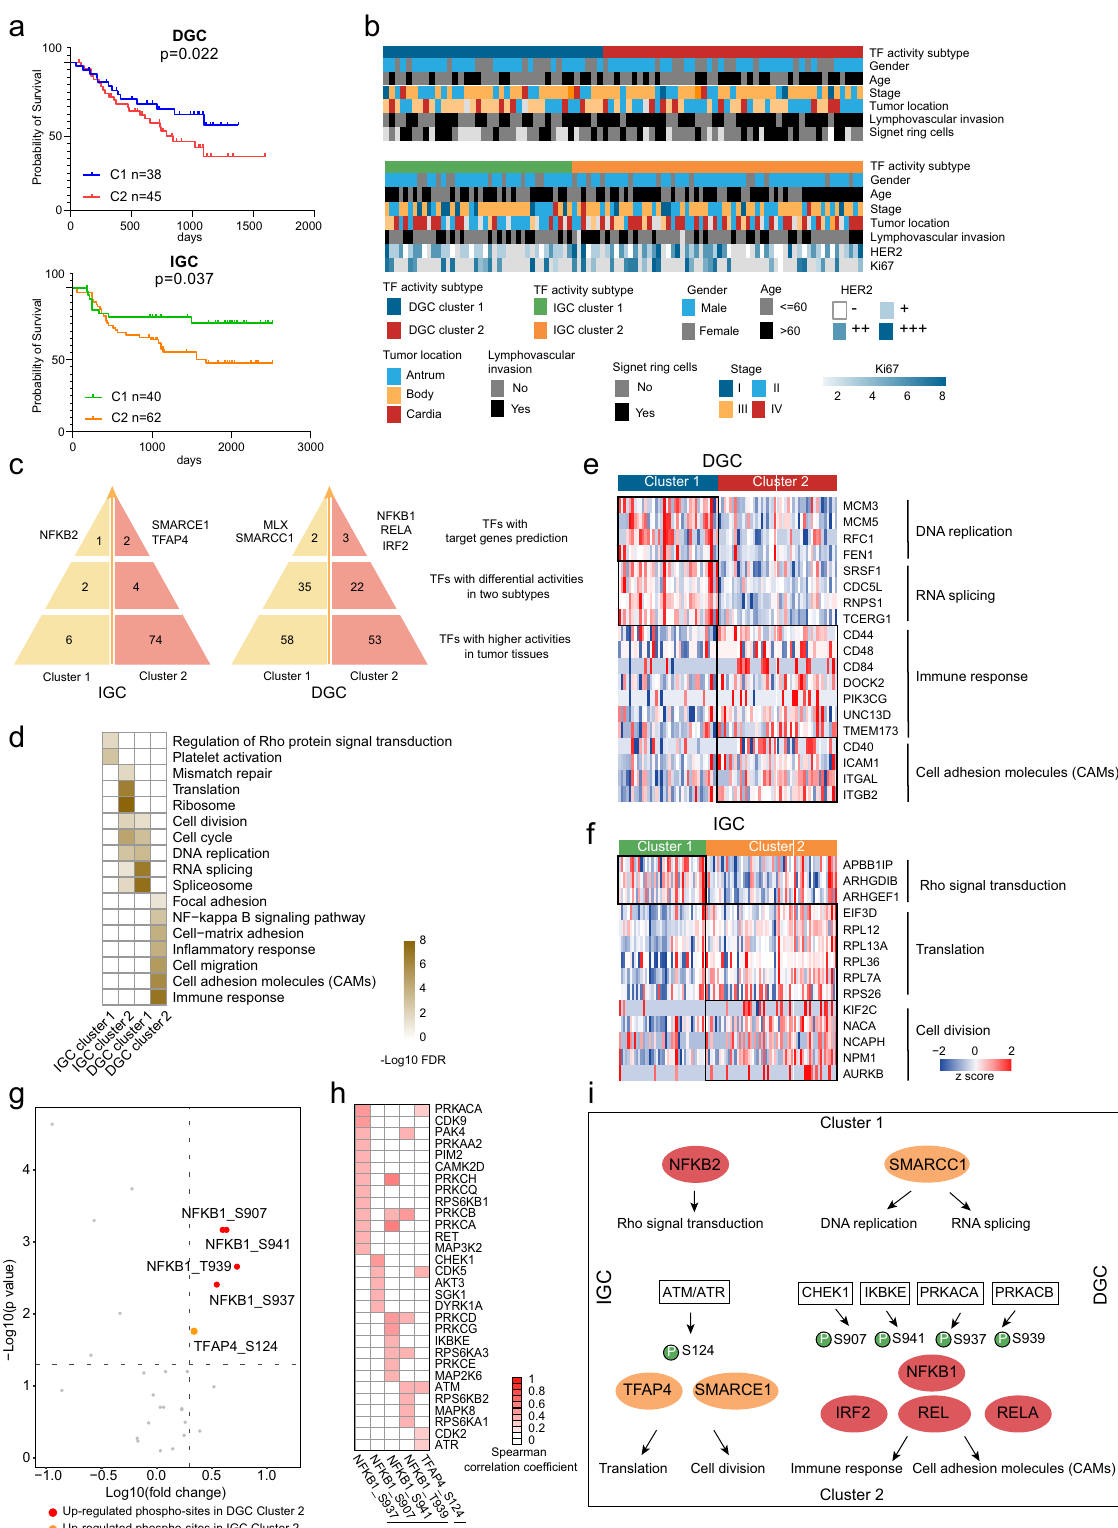
(Supplementary Fig. 9). Then, we summarized these subtyping results from individual dataset. As shown in Supplementary Table 2, except correspondence between phospho-proteomic subtypes and TF activity-based subtypes in IGC, the statistical results of classi fi cation concordance among subtypes based on three datasets were all signi fi cant (chi-square test, p <0.05). These results